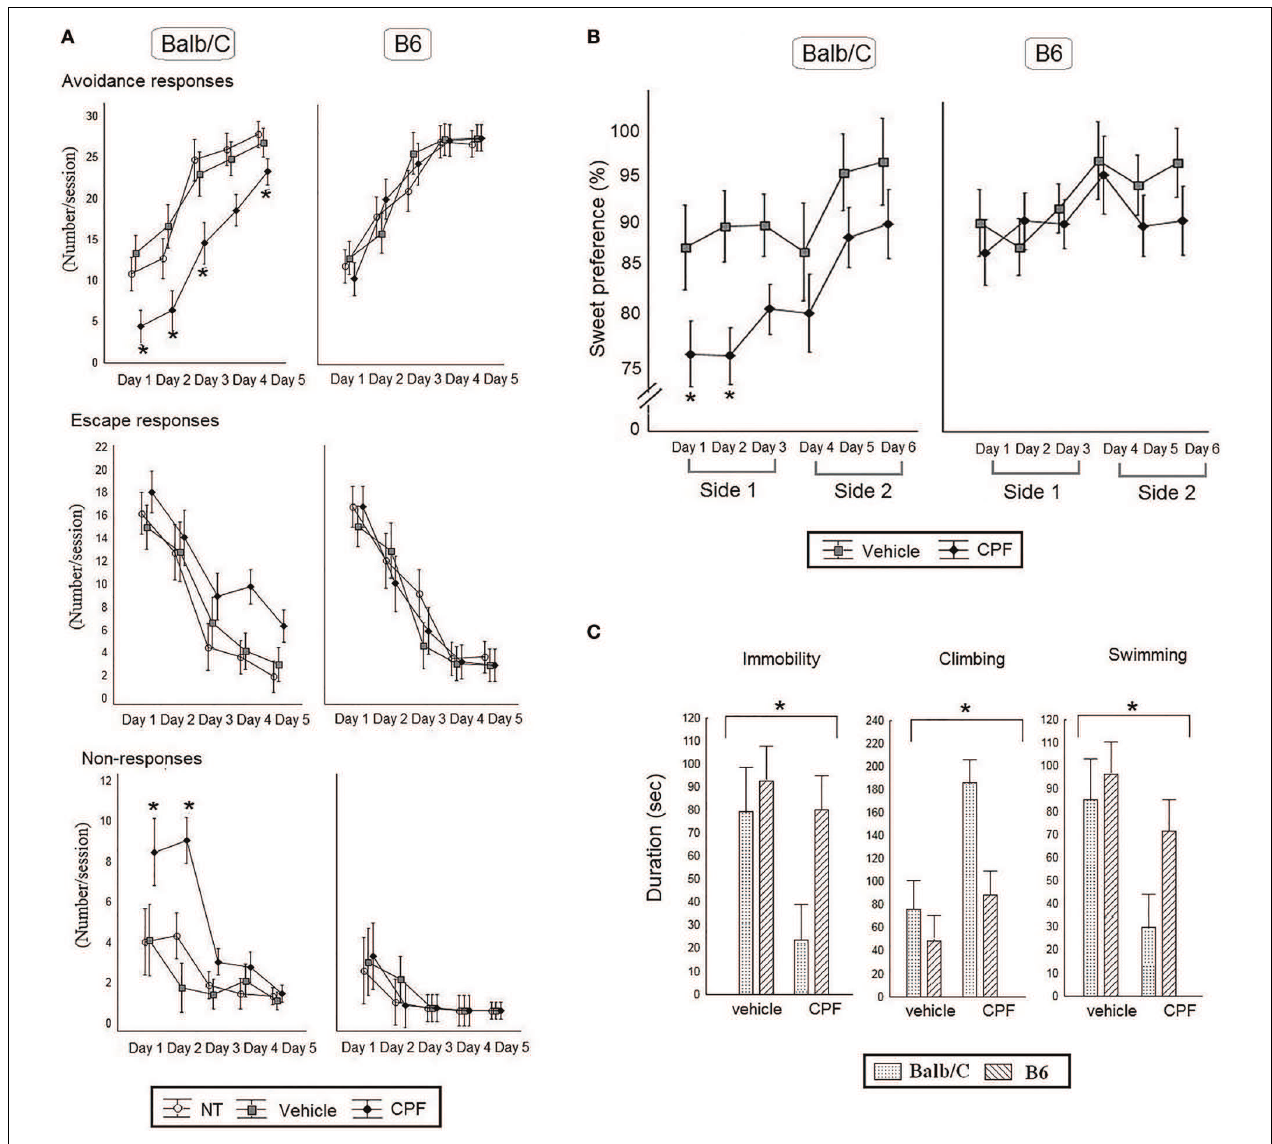
the water and sucrose bottles was switched every 3 days (side 1 and side 2). * p < 0 . 05 CPF vs. vehicle in Balb/C on day 1 and 2. (C) The average times (Mean ( ± ) SEM) of immobility, climbing and swimming behaviors during the Forced Swim Test. (B,C) , N = 8 for all mice group except for N = 5 Balb/C